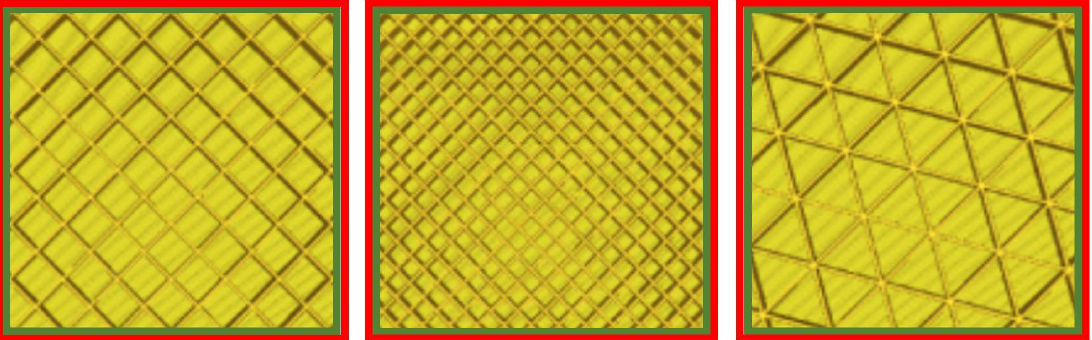
Figure 2. Infill patterns showing triangles ( right ), lines ( centre ), and grid ( left ).